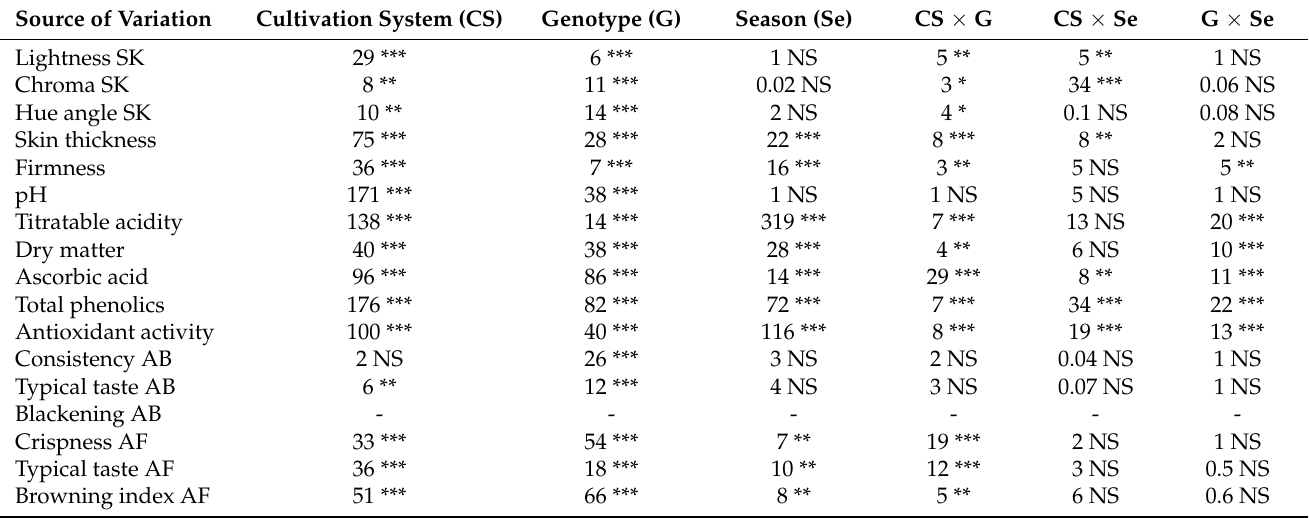
Table 3. F -values resulting from ANOVA for all studied